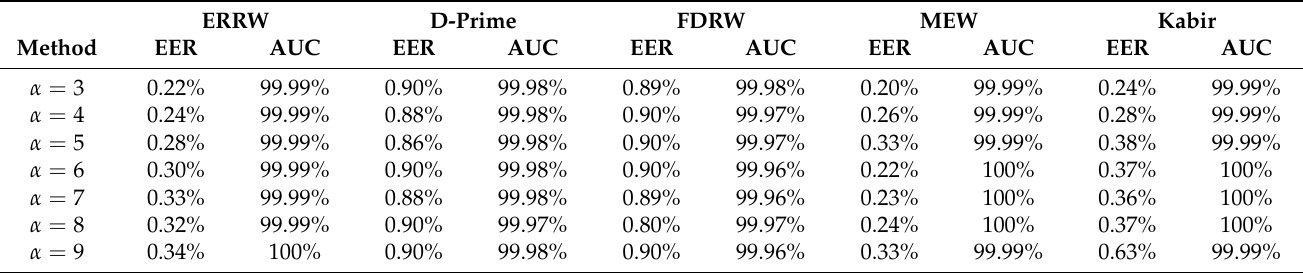
Table 3. EER and AUC values obtained using various fusion methods and α values for β = 3.